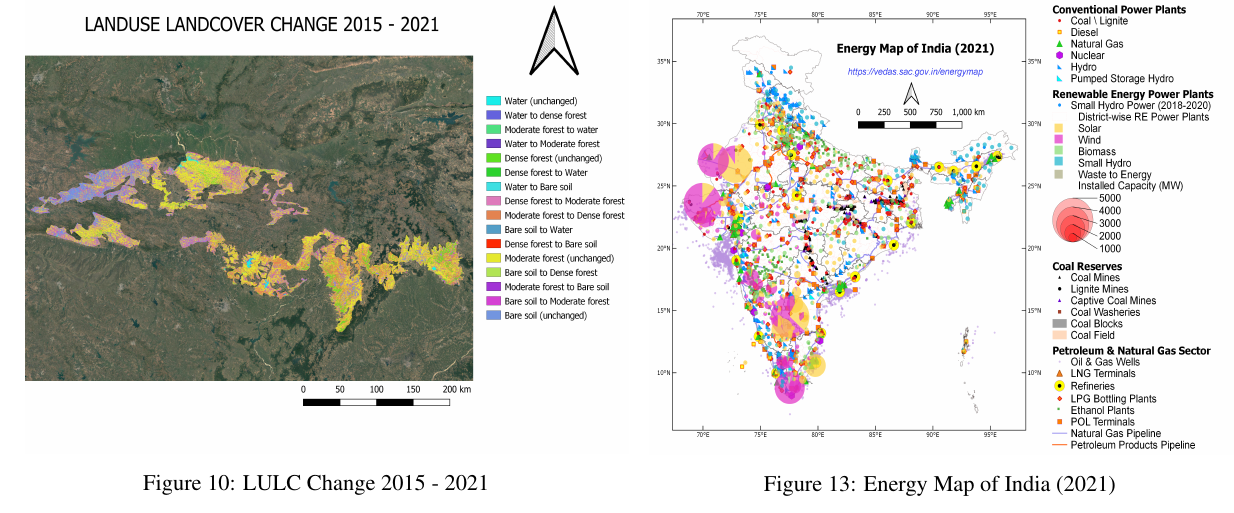
Figure 13: Energy Map of India